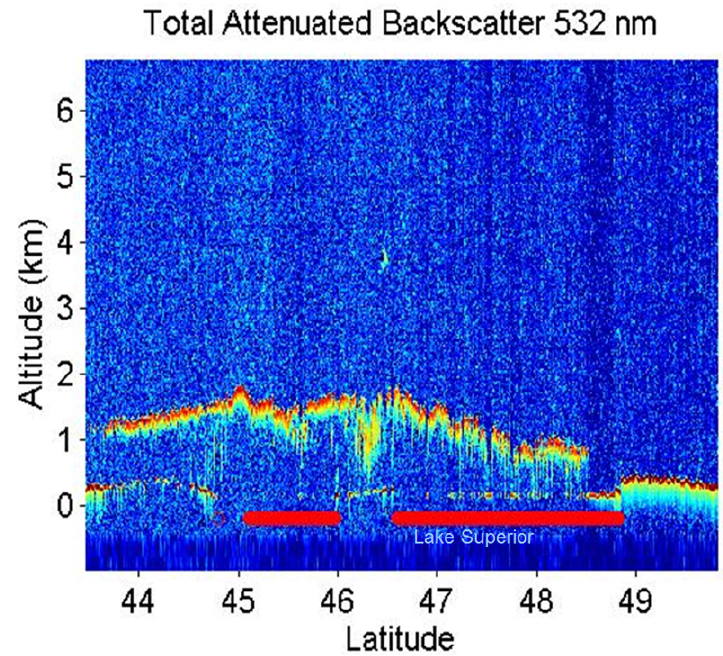
Figure 13. Lidar observations over Lake Superior on 5 February 2007 showing the increase of cloud top altitude downwind, wind direction is from right to left. The right red bar indicates the location of Lake Superior that the lidar sampled and the left most red line Lake Michigan